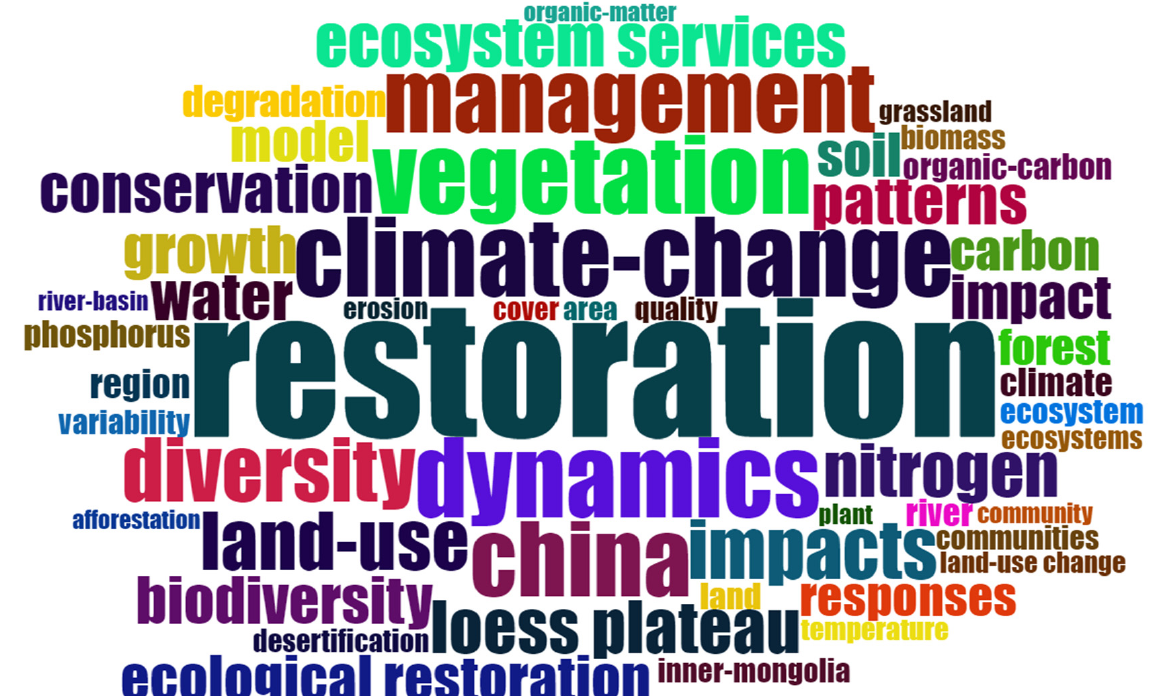
Figure 7. Cloud graph of high-frequency keywords in the field of ecological restoration from 1990 to 2022.